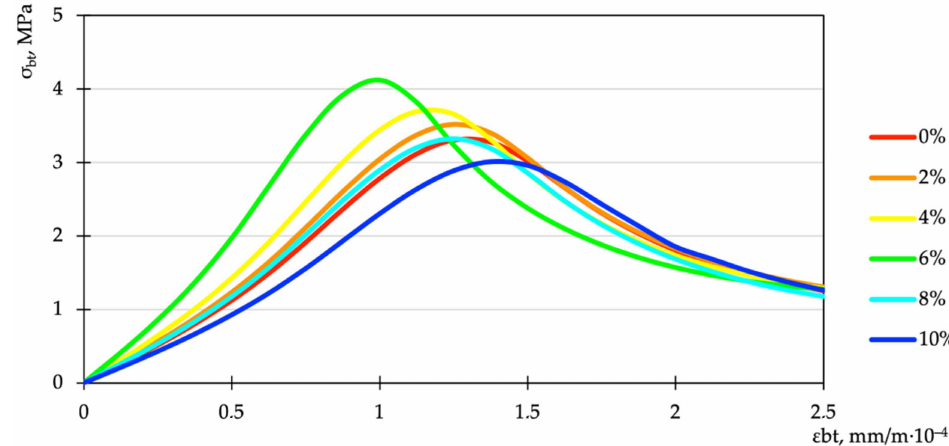
Figure 13. Tensile stress-strain